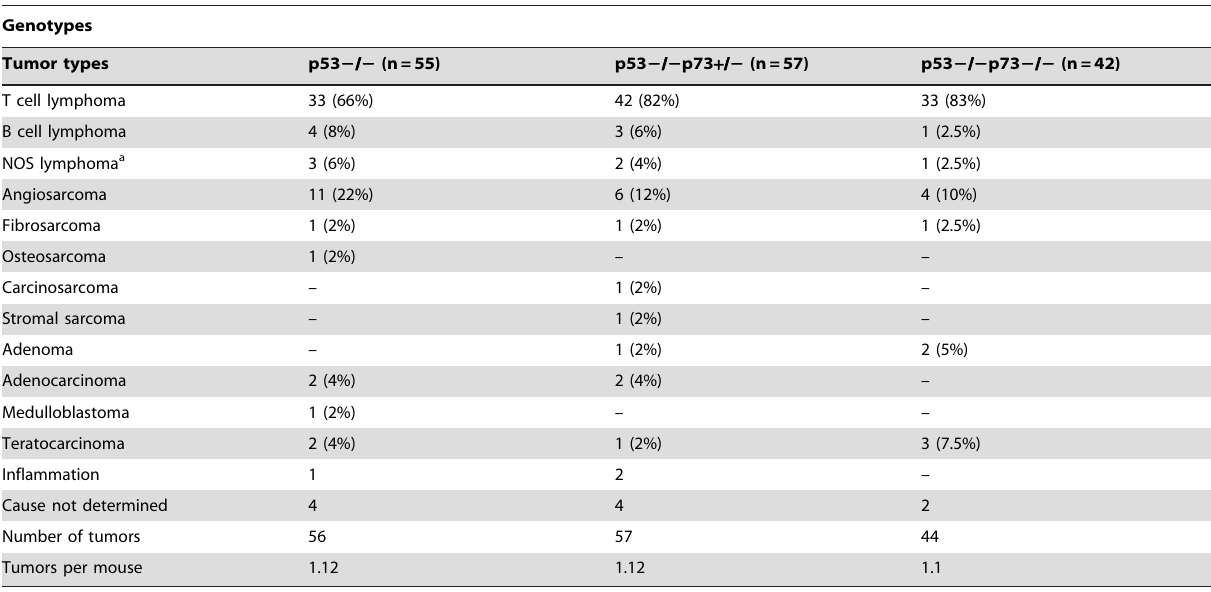
Table 1. Tumor spectrum of p53 2 / 2 mice with zero, one, or two p73 alleles.